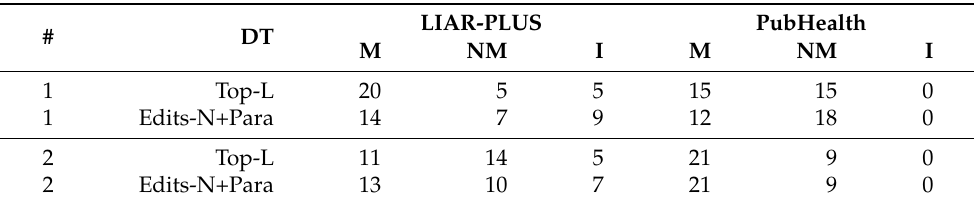
Table A1. Results of manual evaluation for second task, i.e., predicting veracity label. DT refers to data type, # refers to annotator number, M/NM refers to number of matches/non-matches between annotator labels and original labels and I refers to number of times annotators found an explanation not sufficient to predict a